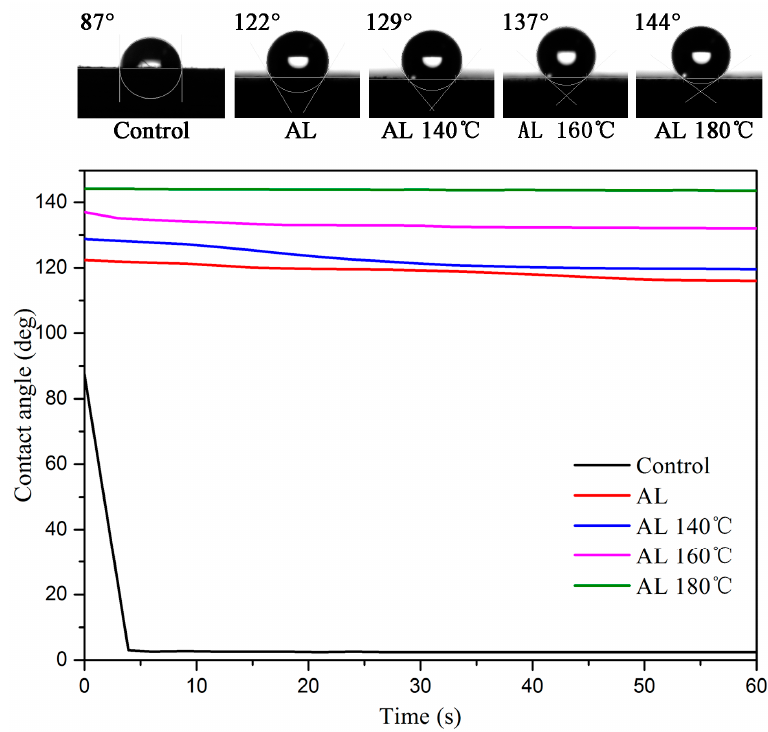
Figure 5. Initial contact angle and contact angle as a function of time for the samples.